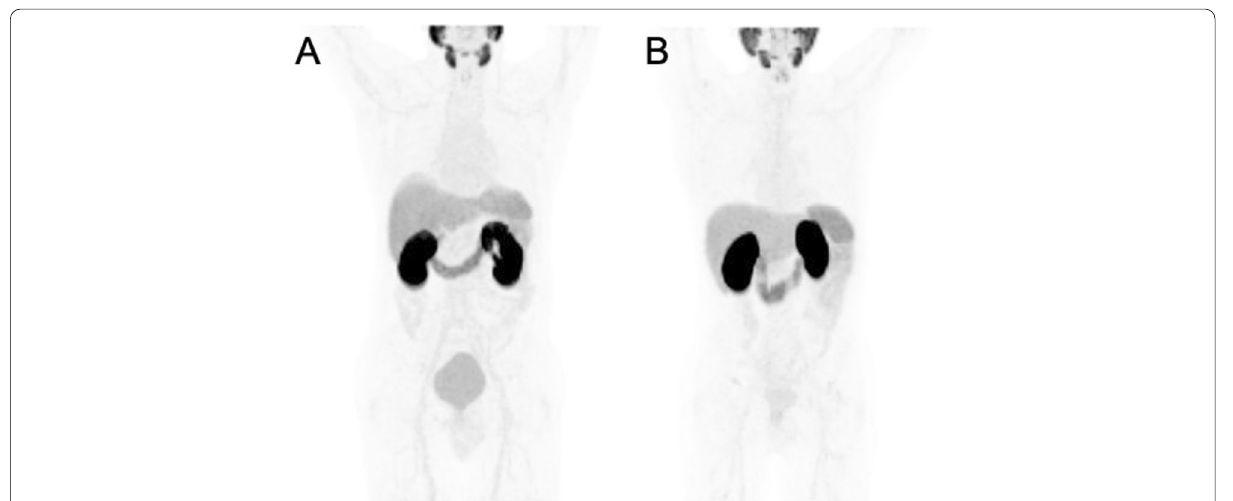
Fig. 2 Maximum intensity projection images of patients with normal biodistribution of 18 F‑rhPSMA‑7 ( A ) and 18 F‑rhPSMA‑7.3 ( B ),